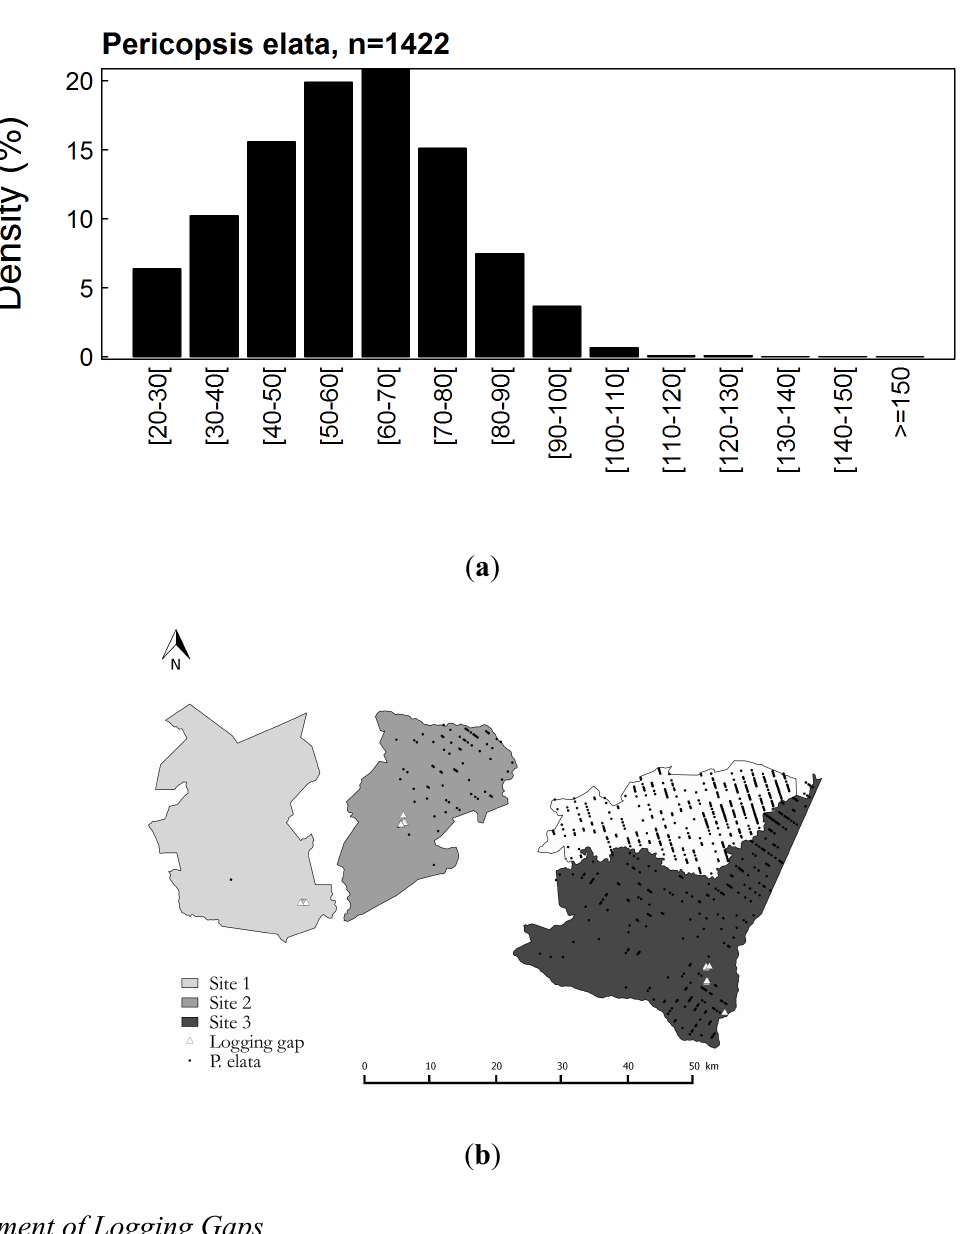
Figure 1. ( a ) Diameter distribution of Pericopsis elata in the area managed by the Pallisco logging company in south-eastern Cameroon; ( b ) Spatial distribution of P. elata in the study site along management inventory line-transects (diameter at breast height ≥ 20